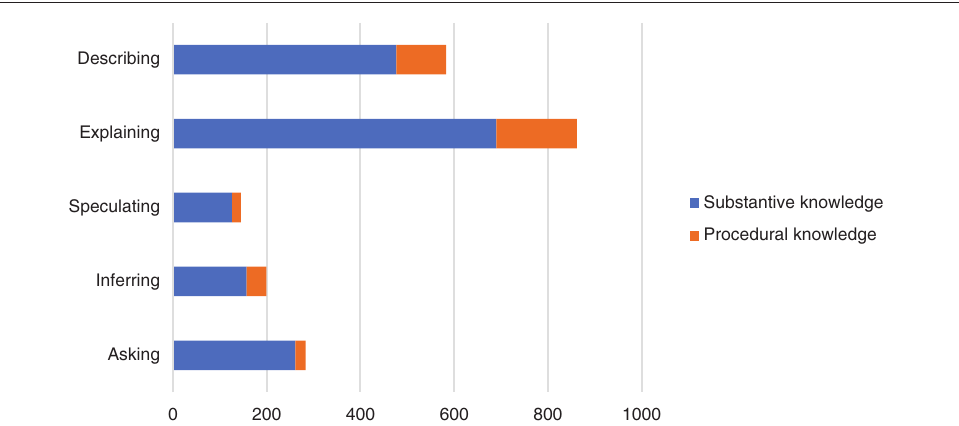
Figure 2: Frequency of strategies students used to construct historical knowledge Especially regarding the concepts of ‘communism’ and ‘democracy’, which were regularly encountered in ‘The Cold War’ lessons, students described how Lech Wałe˛sa referred to communism as ‘a monster’. Kyle explained the concept of democracy in the context of the fall of the Berlin Wall thus: ‘It’s as if each blow is ushering democracy. It was a ray of light for democracy.’ Moreover, from Ronald Reagan’s ‘Tear down this Wall’ speech, Simon and Daniel inferred that ‘communism was weak’ and that ‘it was over by this time’. When considering whether people were expecting that the developments of 8 November 1989 could ever happen, typical speculative comments were: ‘The Wall had stood for 28 years and, therefore, after all that time it would not fall’ (Noel); ‘I think otherwise. The communists had been dragging their feet, and they could suppose that one day it would fall’ (Daniel). Questions were asked in relation to both substantive and procedural